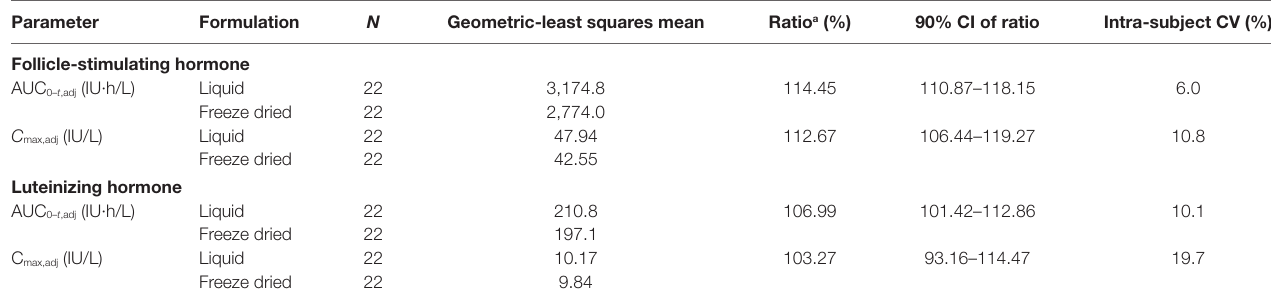
TaBlE 2 | Bioequivalence results.